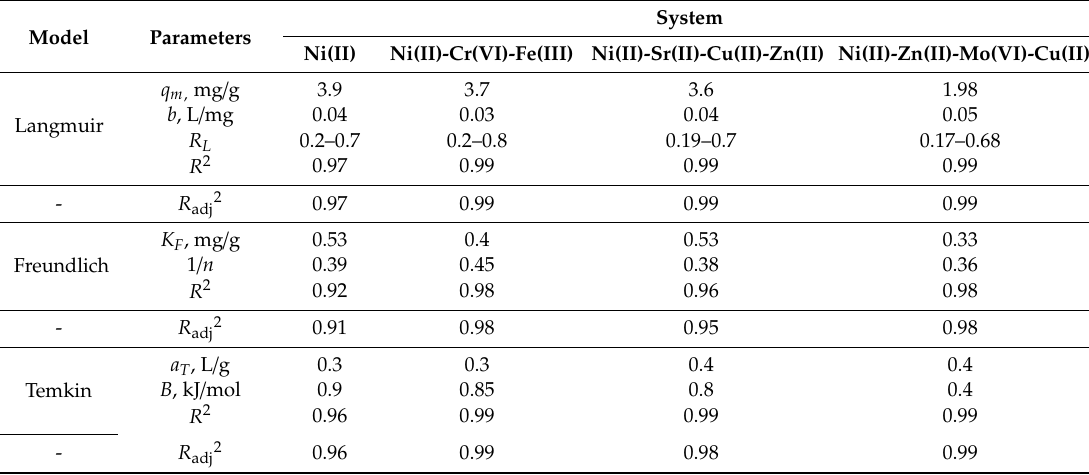
Table 5. The parameters of the applied adsorption isotherm